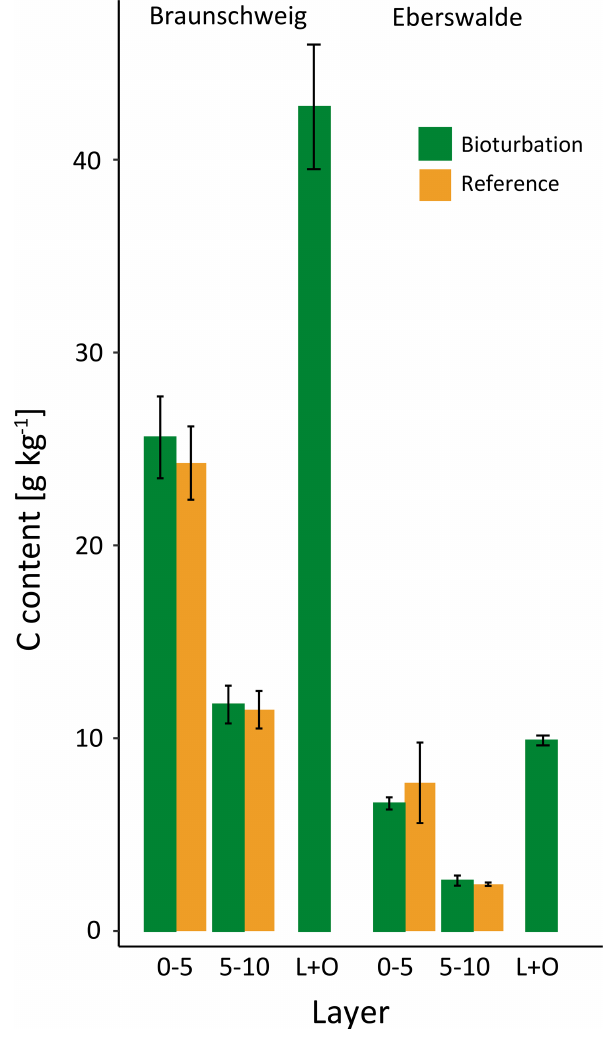
Figure 7. Mean carbon (C) content of the heavy fraction in differ- ent soil depth increments at the Braunschweig and Eberswalde ex- perimental areas. Bars denote standard error. The differences found between reference and bioturbation sites were not